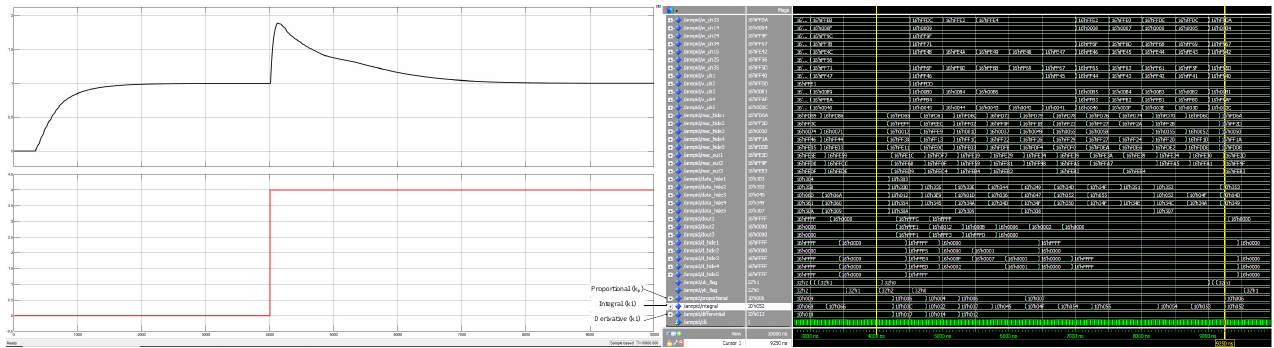
Figure 22. Step response curve and control parameter change diagram after adding interference at t = 4 µ